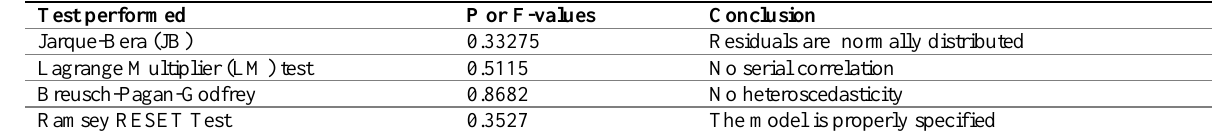
Table 9: Diagnostic stability summary of